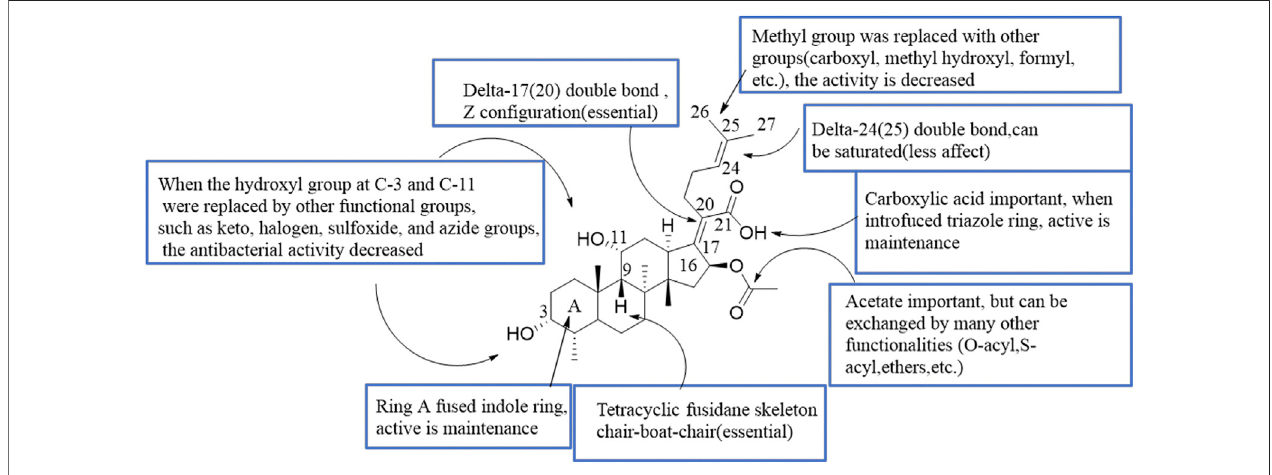
FIGURE 3 | SAR of the antibacterial activity of